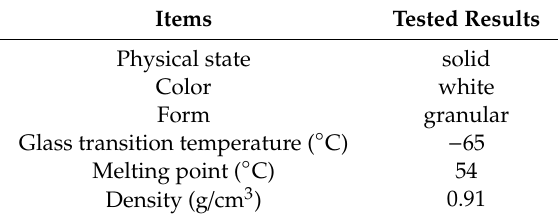
Table 3. Basic properties of Vestenamer ®